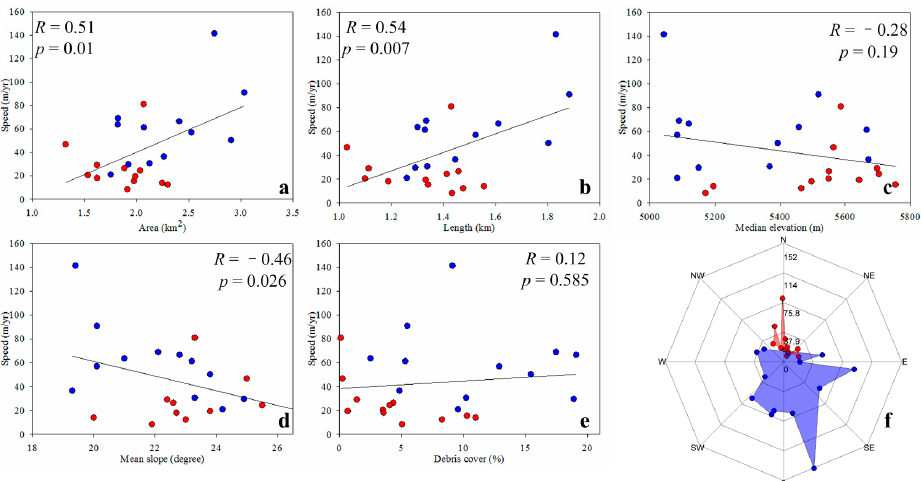
Figure 10. Correlations between glacier speed and individual topographic factors and glaciological characteristics: ( a ) area; ( b ) length; ( c ) median elevation; ( d ) mean slope of a glacier; ( e ) debris cover; and ( f ) mean aspect of a glacier. It should be noted that the area and length in ( a , b ) are plotted on a logarithmic axis. The blue points represent southern slope glaciers; the red points represent northern slope glaciers. R is the linear correlation coefficient and p is the significance level of the respective relation.